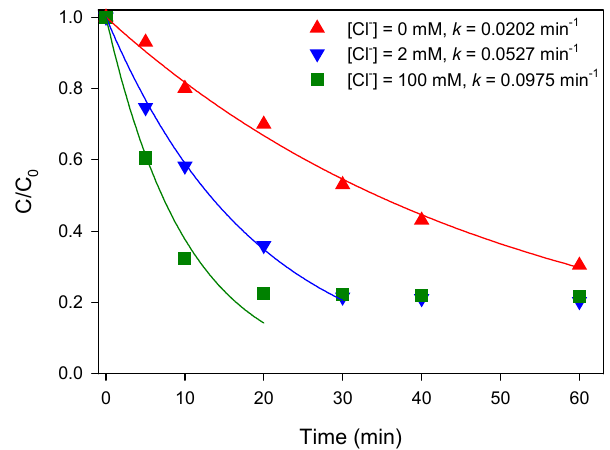
Figure 5. Influence of Cl − on BPA removal by the WMF-Fe 0 /H 2 O 2 process. Reaction conditions: [BPA] 0 = 0.2 mM, [Fe 0 ] 0 = 7 mM, [H 2 O 2 ] 0 = 6 mM.